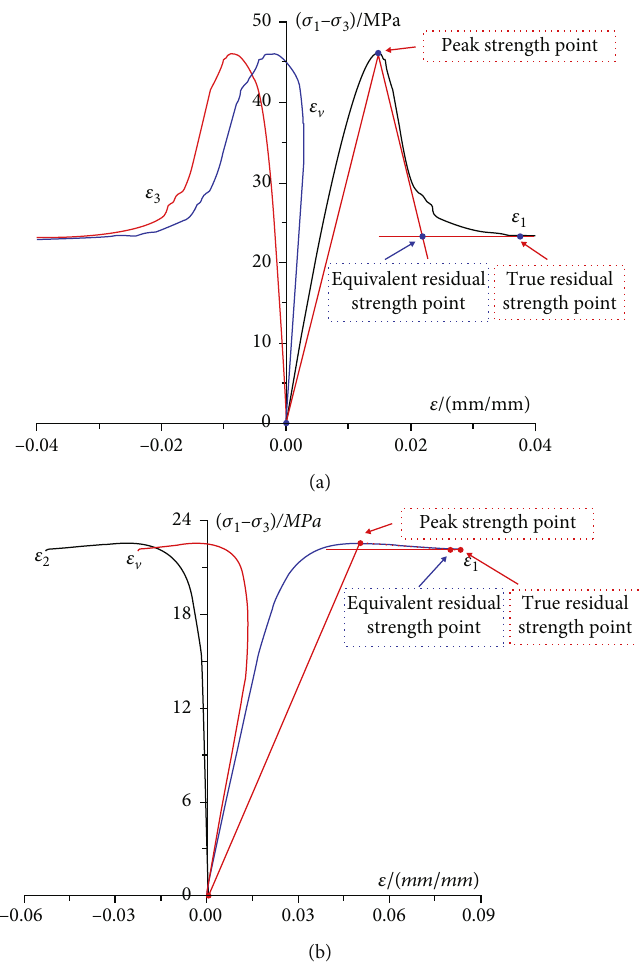
Figure 5: Typical cases of data